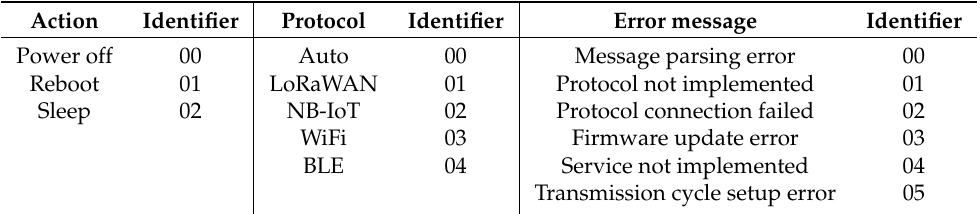
Table 3. Device action options, Protocol options and error messages. The considered protocols include Low Range Wide Area Network (LoRaWAN), Narrowband IoT (NB-IoT), WiFi and Bluetooth Low Energy